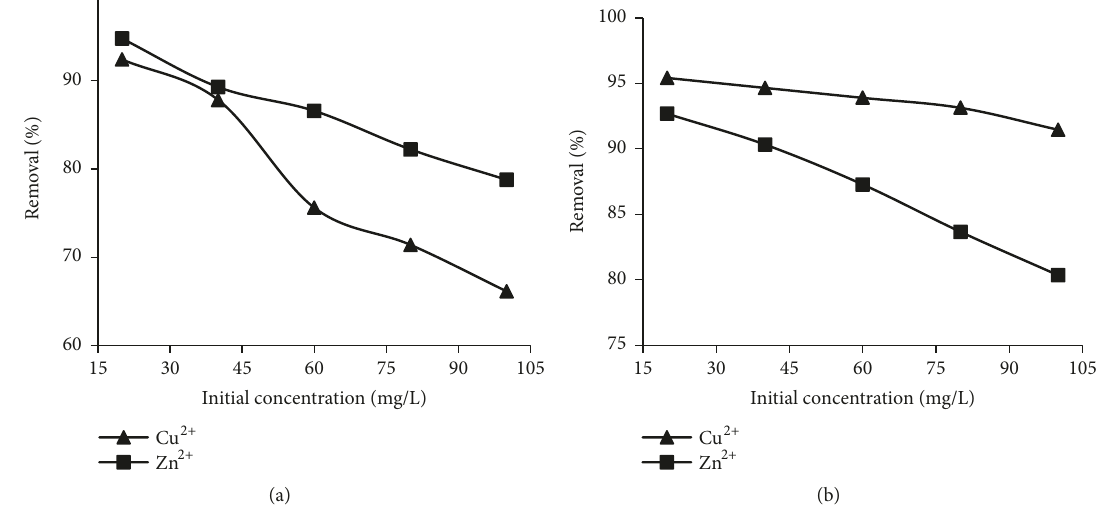
Figure 6: Effect of initial metal ion concentration on pollutant removal using (a) EC and (b) Fe 2 O 3